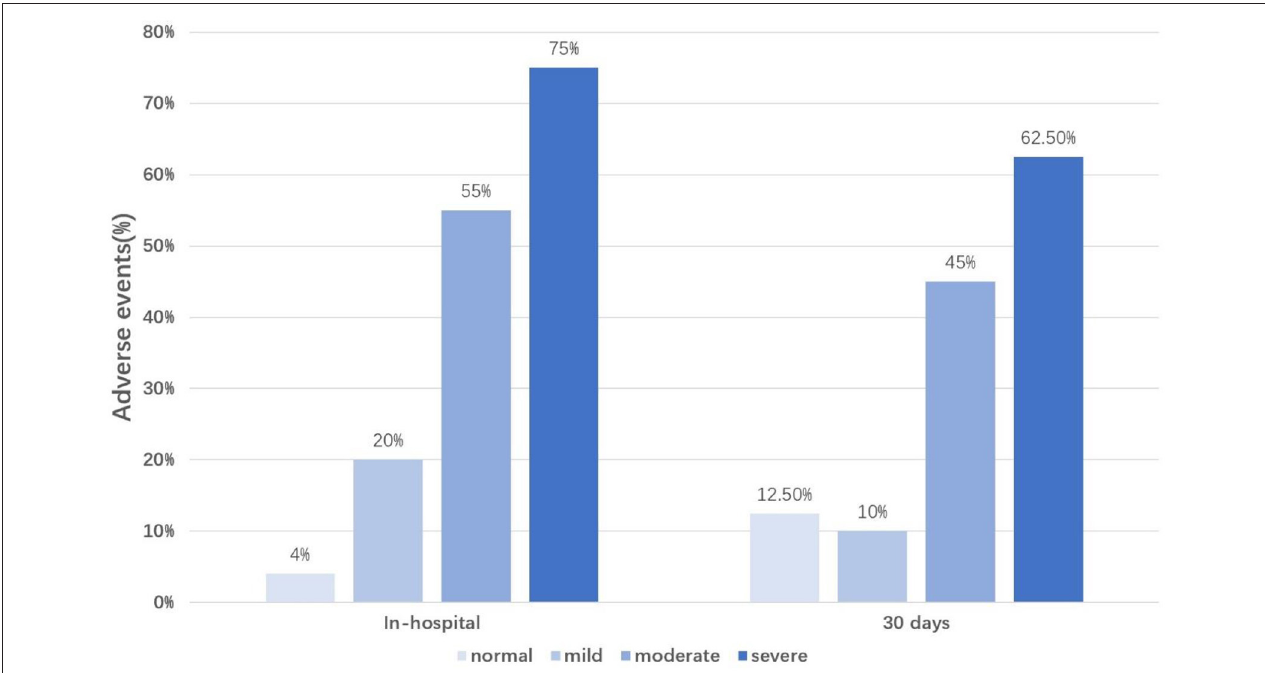
FIGURE 1 | Percentage of adverse events occurrence according to the LUS classification. LUS classification, the total number of B-lines was divided into four groups according to the severity of pulmonary edema (normal, B-line numbers < 5; mild, B-line numbers ≥ 5 and < 15; moderate, B-line numbers ≥ 15 and < 30; severe, B-line numbers ≥ 30); In-hospital, during the hospitalization; 30 days, during 30 days